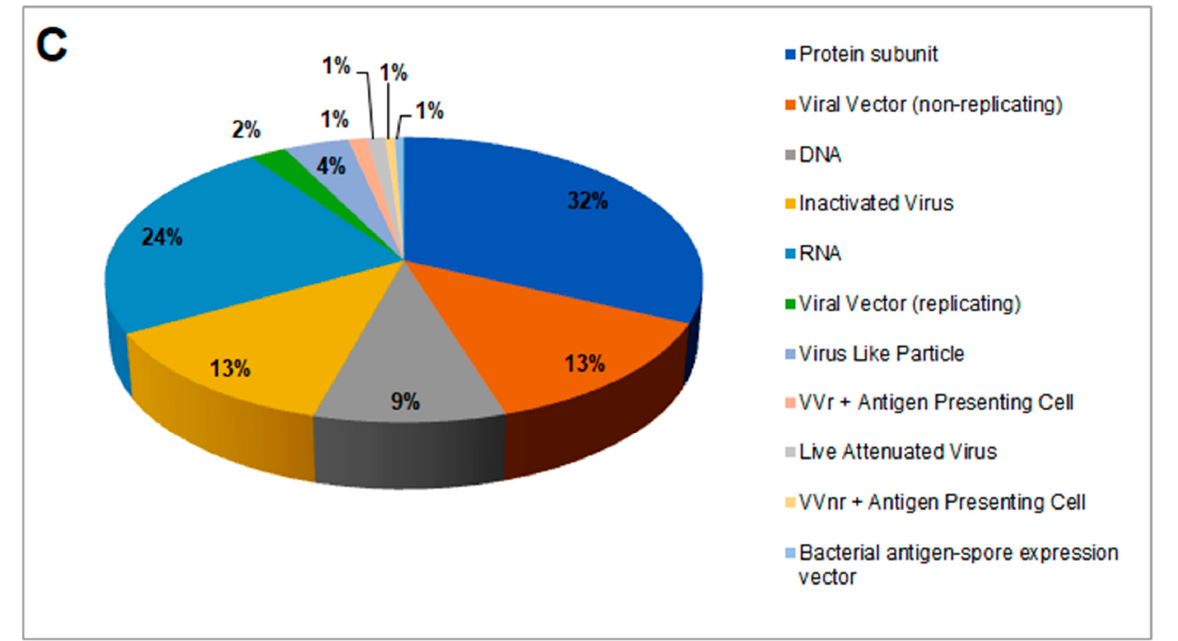
Figure 3. Different vaccine platforms and different clinical trials of vaccines. ( A ) A schematic chart that describes different vaccine platforms. ( B ) A statistical model was developed using the number of clinical trials. ( C ) Percentages of vaccine platforms described through a pie chart.